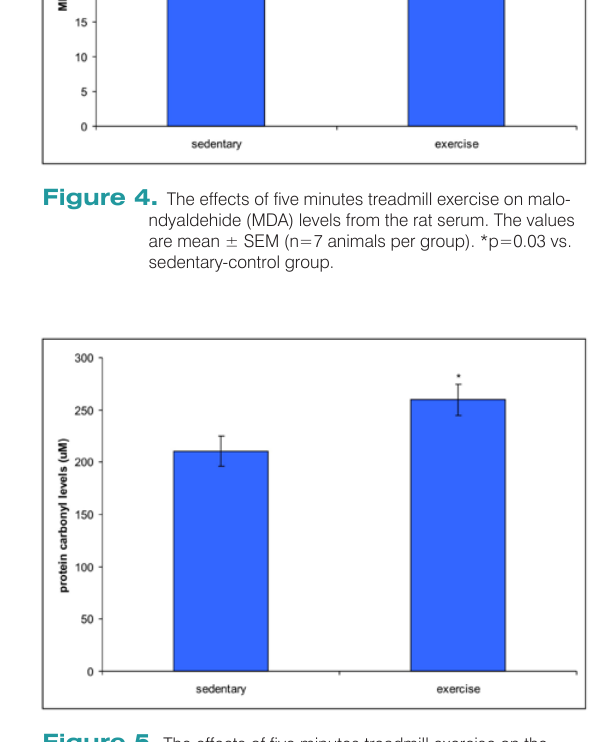
Figure 5. The effects of five minutes treadmill exercise on the levels of protein carbonyls from the rat serum. The values are mean ± SEM (n=7 animals per group). *p=0.03 vs. sedentary-control